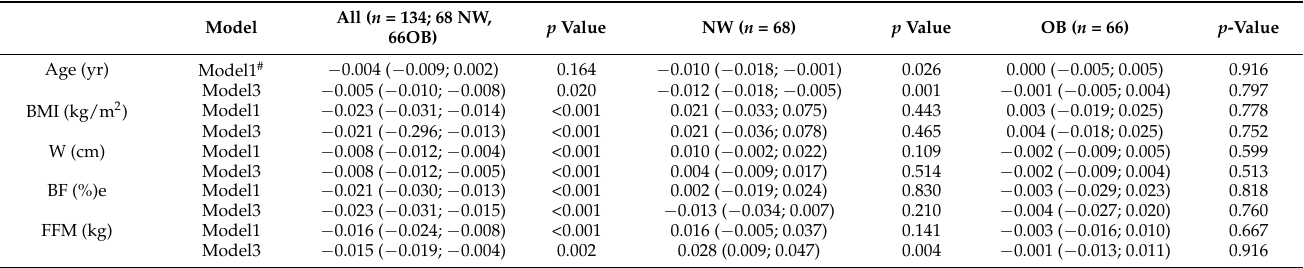
Table 2. Associations between RTL and age, body composition, metabolism, aerobic capacity, oxida- tive stress, and